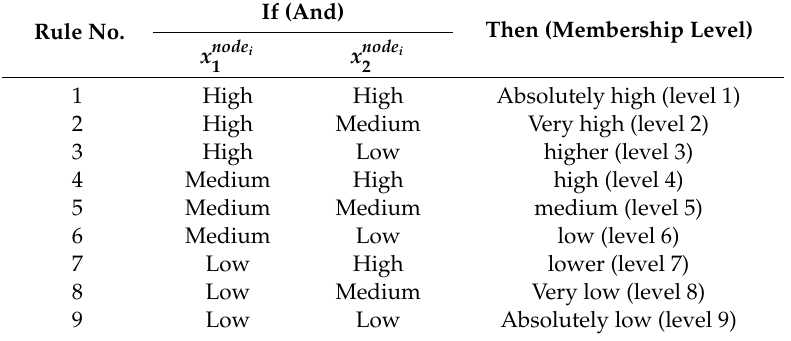
Table A1. Nine ‘If-Then’ rules for the proposed CMFI system.